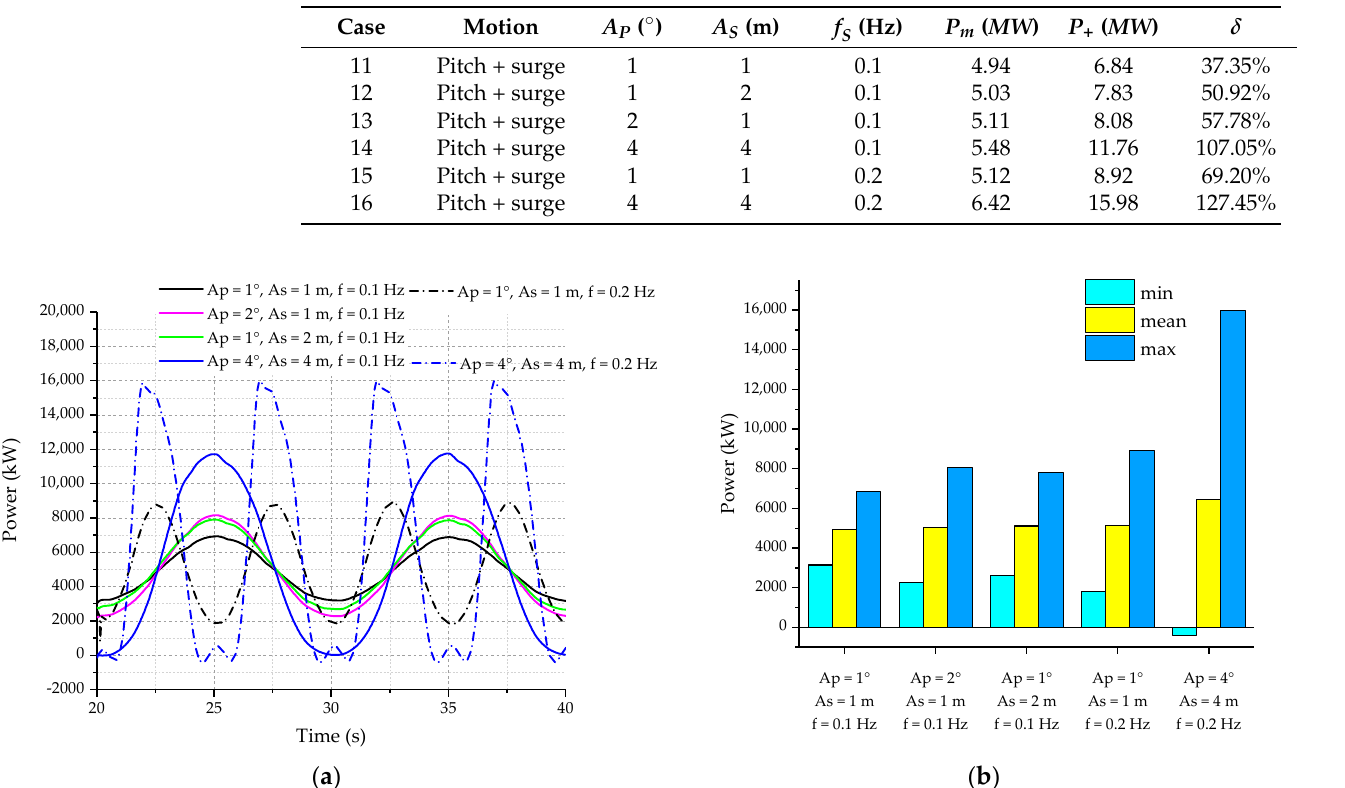
Figure 13. Combined motion analysis under case 14 ( A P = 4 ◦ , A S = 4 m, f S = 0.1 Hz ). Table 6. Cases of same-phase combined motion.